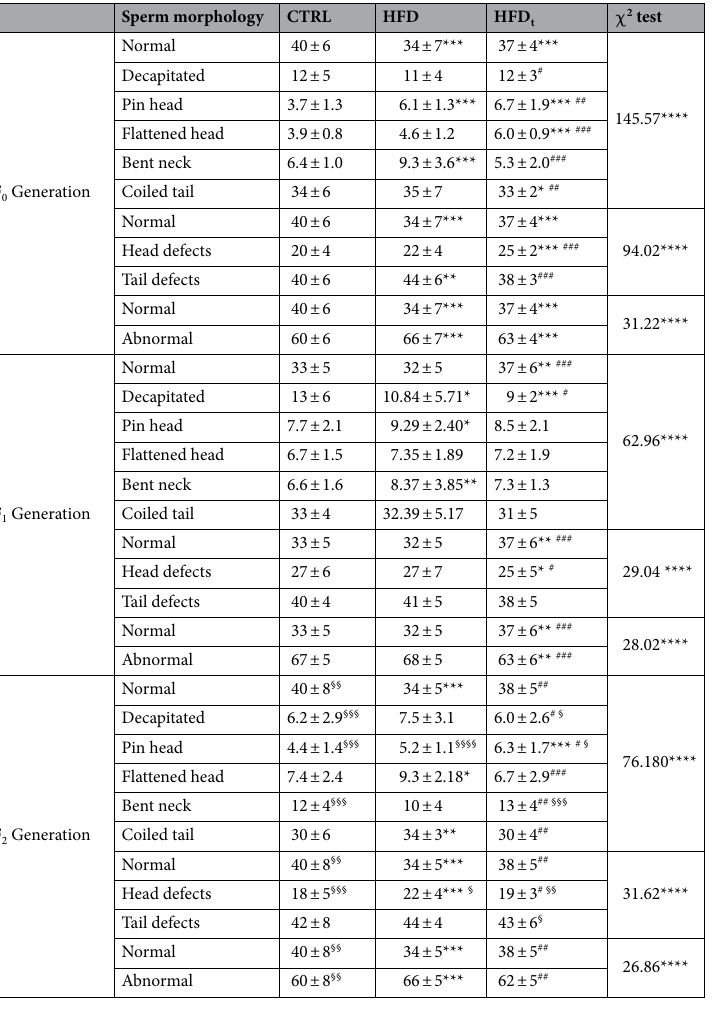
Table 1. Sperm morphology across generations (n = 12 per group in each generation). Data is presented as the mean (%) ± standard deviation. Epidydimal sperm was obtained from mice immediately after sacrifice, at 200 days post-weaning. The distribution of sperm defects across different experimental groups, in each generation, was tested by χ 2 test of independence. Comparisons within sperm morphology categories were obtained with the Z-test for column proportions with Bonferroni correction. Two-way ANOVA with Šidak correction was used to compare each diet group in F 1 Generation against its F 2 counterparts. Significance was considered when p < 0.05. * vs. CTRL; # vs. HFD; § vs. F 1 Generation. Multiple significance signs represent different significance levels: *p < 0.05; **p < 0.01; ***p < 0.001; ****p <